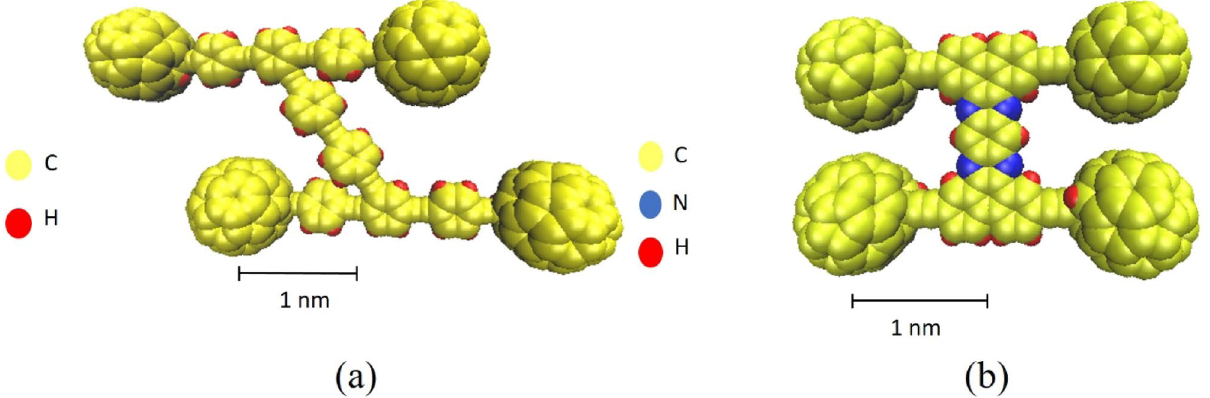
Figure 2. Top view of a fullerene-based molecular machine with four wheels: ( a ) Nanocar, the size of the exible-chassis machine is approximately 3 nm × 4 nm , ( b ) nanotruck, the chassis is practically rigid and due to the presence of nitrogen atoms in the chassis, it can potentially be attached to and carry other molecules. Its size is about 2 nm × 3 nm . In both molecules, the carbon, hydrogen, and nitrogen atoms are shown in gray, white, and blue, respectively.